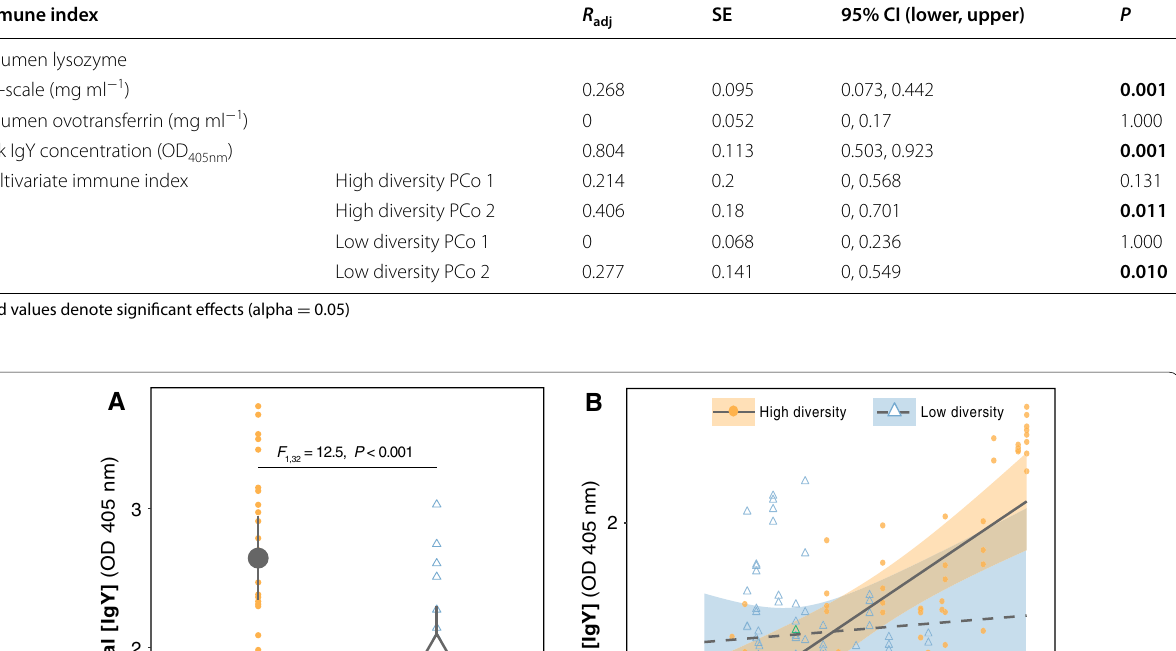
Fig. 3 Experimental effect on the relationship between maternal and egg yolk IgY concentrations. A Elevated maternal IgY concentration in a high diversity microbial environment. B Egg IgY concentration increases with maternal IgY concentration only in the high diversity microbial environment. Lines depict linear mixed model predictions ( 95% ±